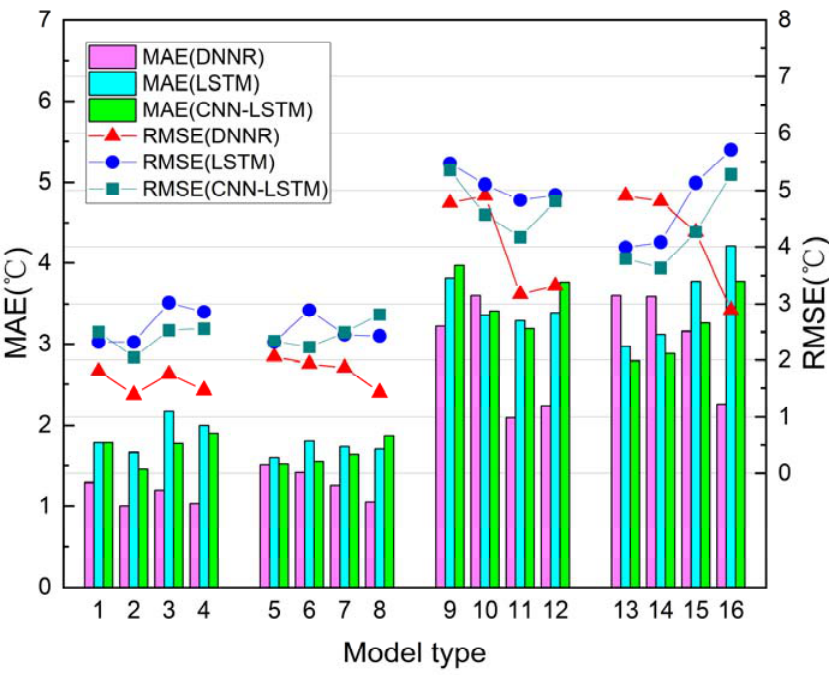
Figure 10. The RMSE and MAE of the best experimental model for Greenhouse A temperature under 16 datasets.